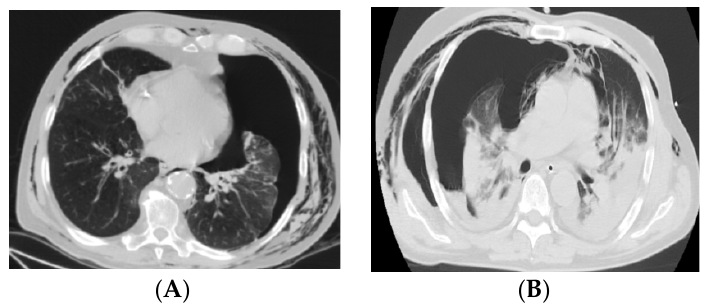
Figure 1. CT images for COVID-19 and non-COVID-19 pneumothorax: ( A ) left pneumothorax in a patient without COVID-19; ( B ) right pneumothorax in a patient with COVID-19. Table 3. Comparative values of laboratory findings and imaging diagnosis. The symptoms were more intense in patients with COVID-19 pneumothorax. This group included: 21 patients with pneumothorax after intubation and mechanical ventilation, 9 patients with pneumothorax while on CPAP ventilatory support, and 4 patients with pneumothorax without ventilatory support. The group of patients with non-COVID-19 pneumothorax had sudden onset of dyspnea and chest pain.